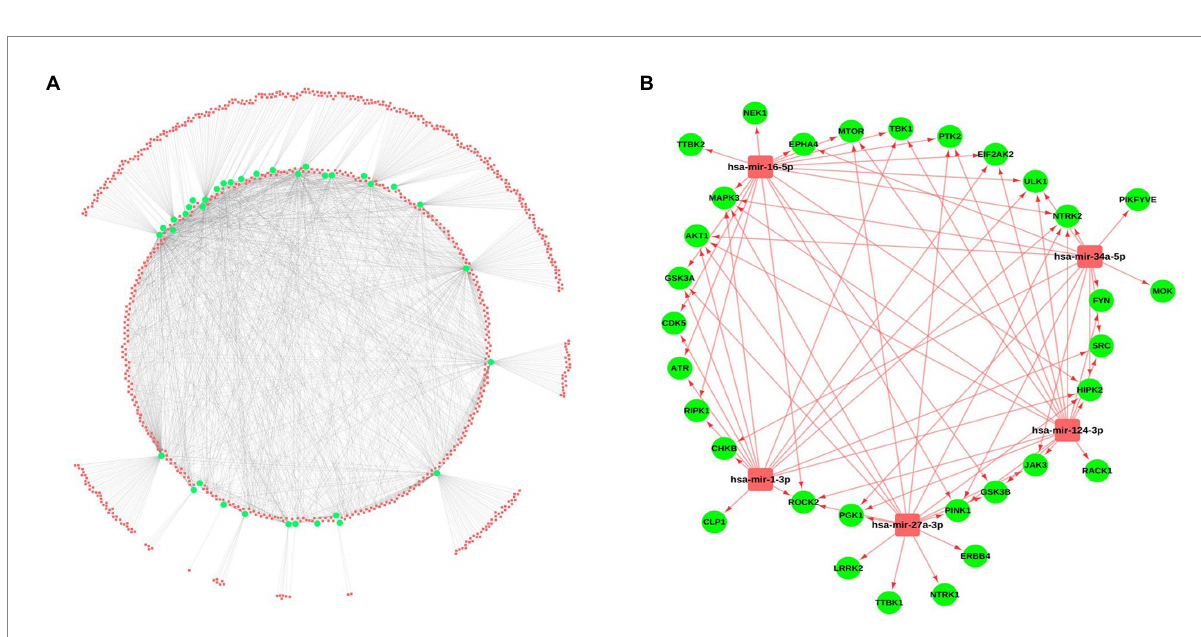
FIGURE 4 miRNA-kinases interaction network. (A) The kinases (Green) show interaction with the miRNAs from several databases including miRNet, miRTarBase, and TarBase. (B) Interaction of the top 5 miRNAs, selected based on a high degree of connectivity with 29 kinases.